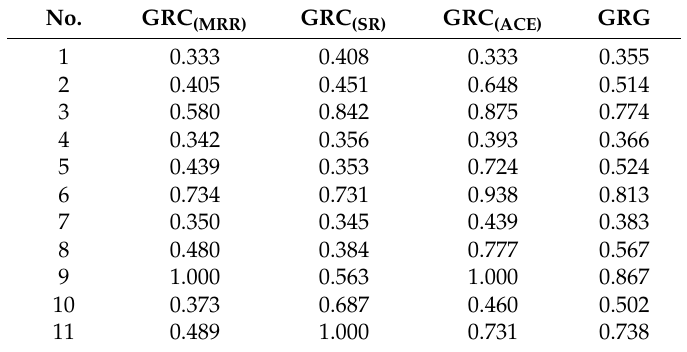
Table 4. Grey relation coefficients (GRC) and Grey relation grade (GRG) values for each response.